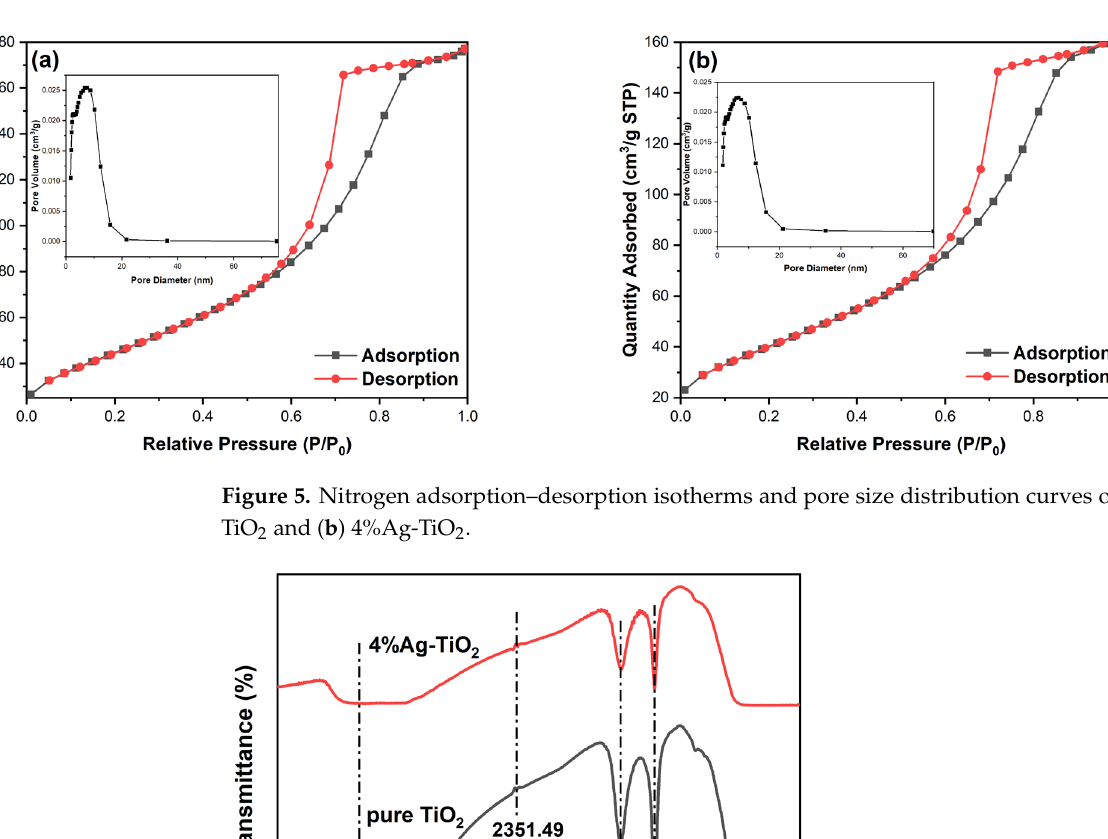
Figure 5. Nitrogen adsorption–desorption isotherms and pore size distribution curves of ( a ) pure TiO 2 and ( b ) 4%Ag-TiO 2 .